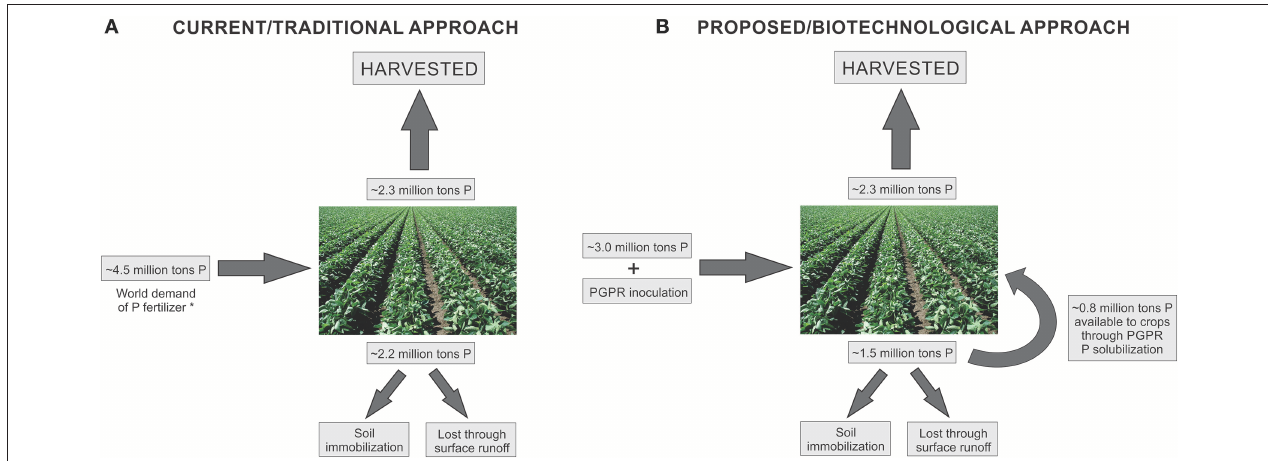
FIGURE 1 | Schematic model of current/traditional approach (A) and proposed/biotechnological approach (B) . *On the current agricultural approach, world demand of P fertilizer is approximately 4.5 million tons, according to FAO (http://www.fao.org/3/a-i6895e.pdf). From these, 2.2 million tons are unavailable to crops (soil immobilization or surface runoff), and 2.3 million tons are harvested with the crops. On the proposed biotechnological approach, we suggest the reduction of up to 33% on the P fertilizer dose applied on the soil, along with PGPR inoculation. Such reduction on P fertilizer together with PGPR inoculation would result in less P unavailable to the crops. Nearly half of such unavailable P can be further solubilized by PGPR and uptaked by the crops, resulting in the same 2.3 million tons of harvested P (adapted from Roy et al.,